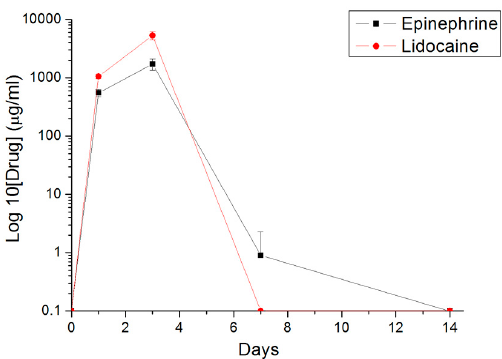
Figure 6. In vivo release of lidocaine and epinephrine from the nanofibrous membranes. Release peaks were observed at Days 1 and 3, after which the drug concentration dropped significantly at Day